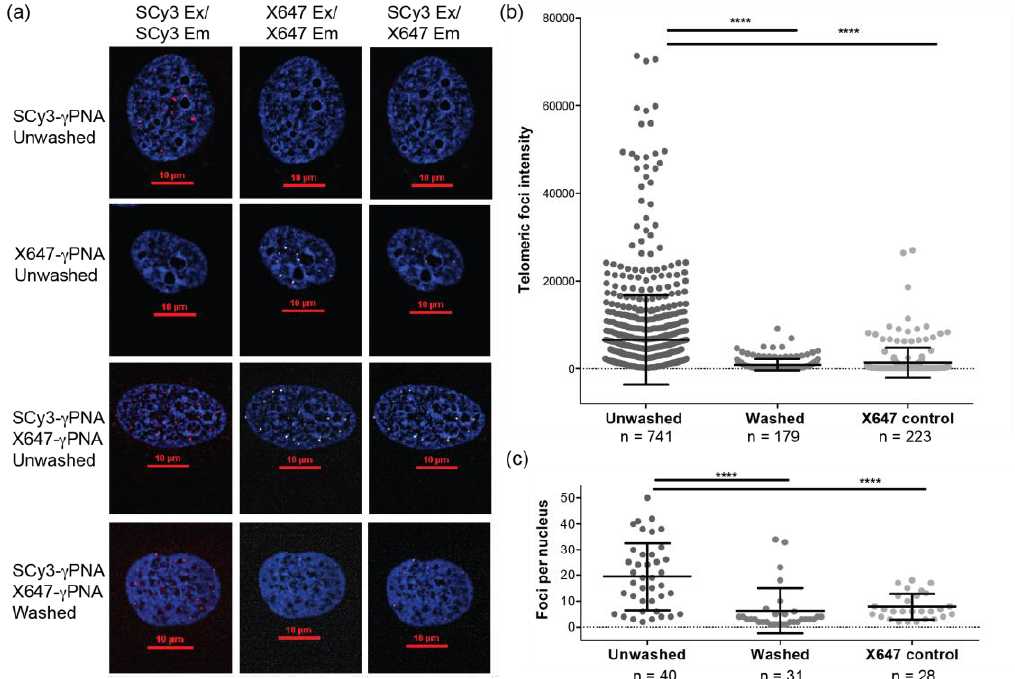
Figure 4. FRET pair miniprobes stain telomeres in human cells. ( a ) Interphase U2OS cell nuclei were stained with the SCy3-γPNA, X647-γPNA, or a mix of both by fluorescence in situ hybridization (FISH), with or without wash steps. Images were captured using filters for SCy3 excitation and emission (red), X647 excitation and emission (white) or SCy3 excitation and X647 emission (white, FRET channel). Nuclei were stained with DAPI and imaged with a 60× lens. Fluorescence signal intensity for each telomeric foci; ( b ) and the number of telomeric foci per nucleus; ( c ) in the FRET channel were measured. Data from unwashed SCy3-γPNA + X647-γPNA ( n = 40 nuclei), washed SCy3-γPNA + X647-γPNA ( n = 31 nuclei) and unwashed X647-γPNA alone ( n = 28 nuclei). Mean and SEM from total foci ( b ) or nuclei ( c ) from three independent experiments are shown. **** p < 0.0001, unpaired t -test.